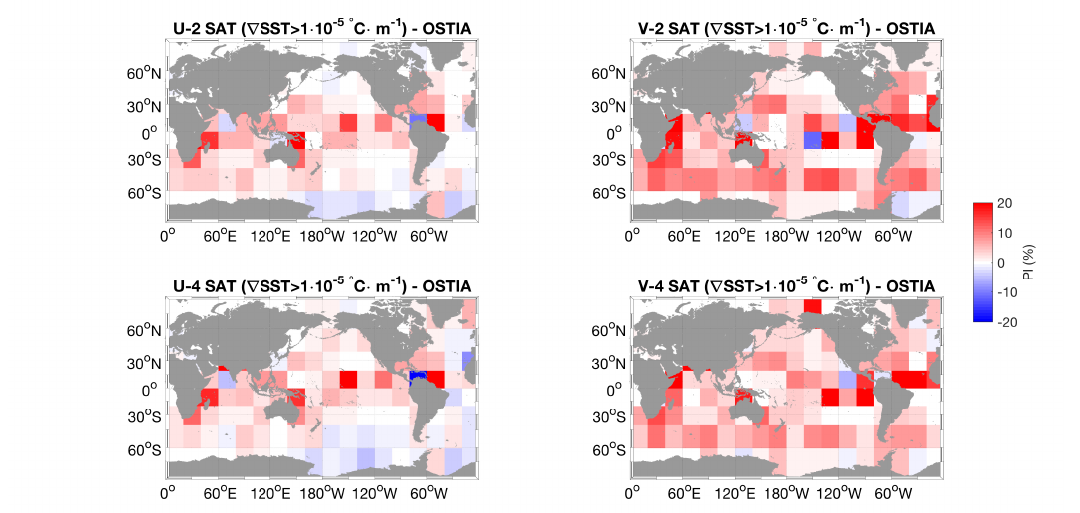
Figure 2. Same as Figure 1. The input SST is Operational Sea Surface Temperature and Sea Ice Analysis